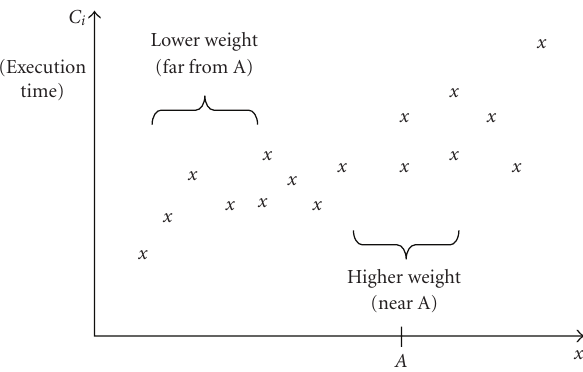
Figure 3: Weights assigning to previous observations.